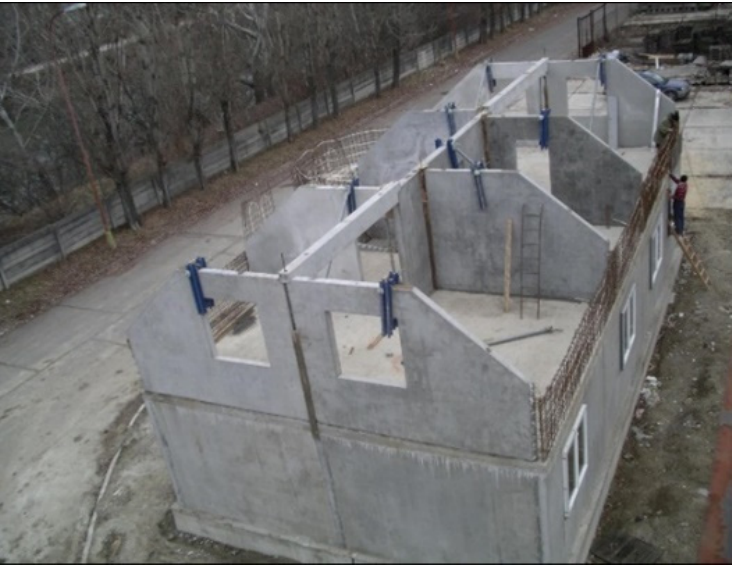
Figure 28. Completion of the ground floor assembly (photo archive: Kalús, D.) [1].